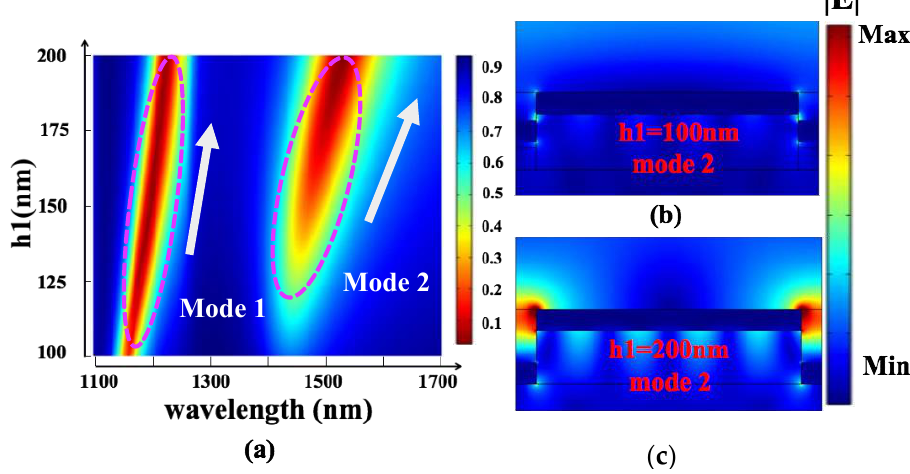
Figure 7. ( a ) The two-dimensional cloud group of device refractive index obtained by scanning the grating height h1 (100 nm – 200 nm). ( b , c ) The electric field distribution of Mode 2 when h1 is 100 nm and 200 nm, respectively.